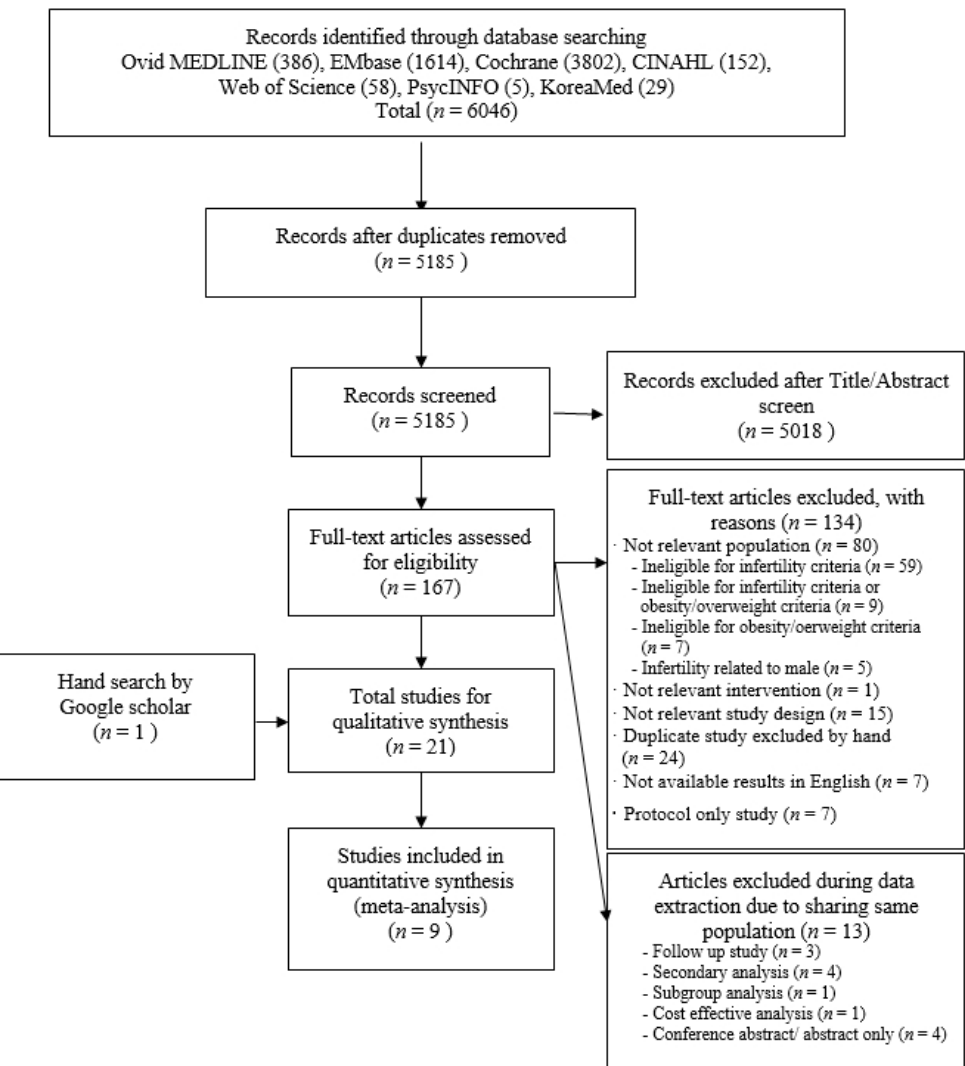
Figure 1. Preferred Reporting Items for Systematic Reviews and Meta-Analyses (PRISMA) flow diagram for the process of selecting included studies in the systematic review.